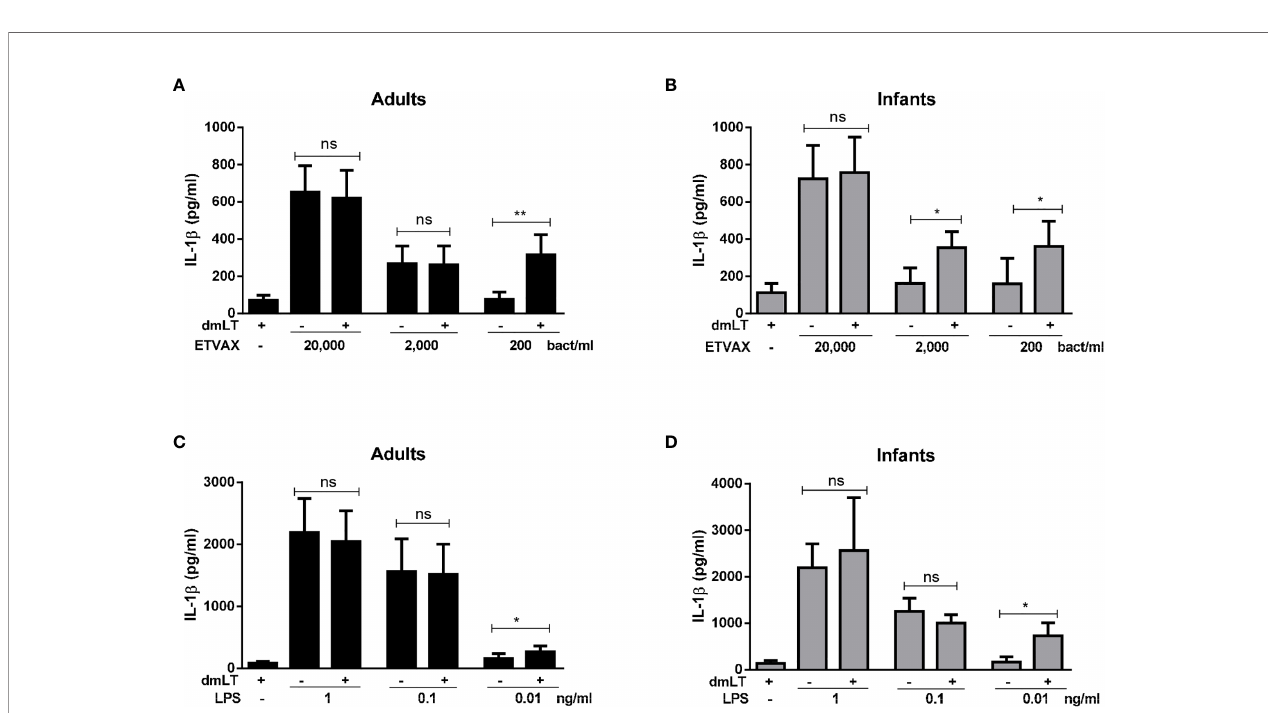
FIGURE 6 | IL-1 b production from PBMCs stimulated with ETVAX WCC or LPS ± dmLT. IL-1 b concentrations in cultures with PBMCs from (A, C) adults and (B, D) infants stimulated with increasing concentrations of ETVAX WCC (200-20,000 bacteria/ml) or ETEC O78 LPS (0.01-1 ng/ml) alone or with 10 µg/ml dmLT. Bars represent mean with SEM of IL-1 b concentrations in culture supernatants (ETEC WCC 2000 bacteria/ml; adults n = 13, infants n = 14, 200 bacteria/ml; adults n = 9, infants n = 9, LPS 0.1 ng/ml; adults n = 12, infants n = 11, LPS 0.01 ng/ml; adults n=6, infants n=6). Statistical analysis was performed with the Wilcoxon matched-pairs signed rank test. * P < 0.05, ** P < 0.01, ns, not signi fi cant; P >